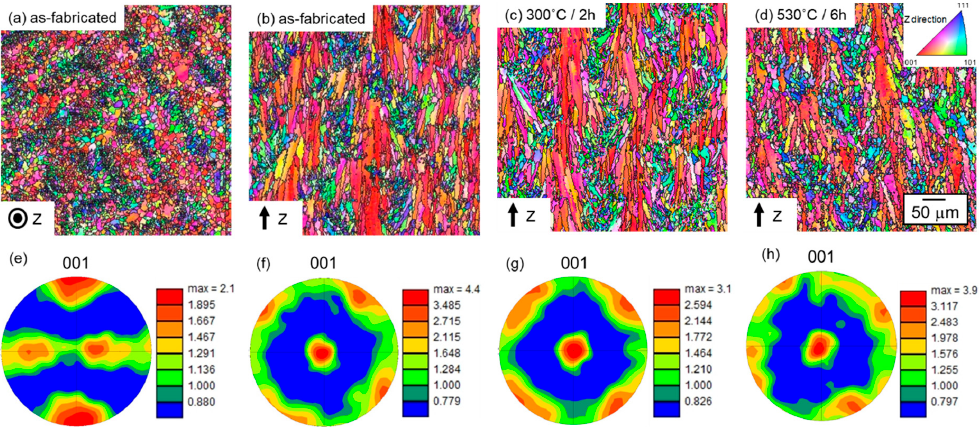
Figure 4. ( a – d ) Orientation color maps and ( e – h ) corresponding (001) pole figures of ( a , b , e , f ) as-fabricated, ( c , g ) 300 °C/2 h annealed and ( d , h ) 530 °C/6 h annealed samples observed from the sections ( a , e ) normal and ( b – d , f – h ) parallel to the building direction (z axis).